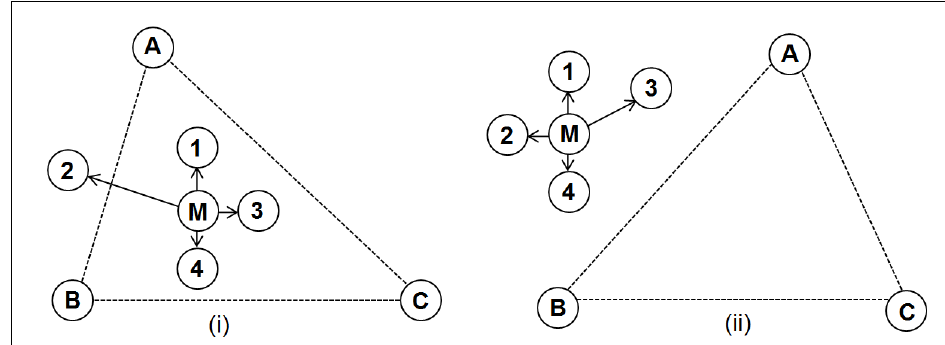
Figure1. In-to-out and out-to-in error